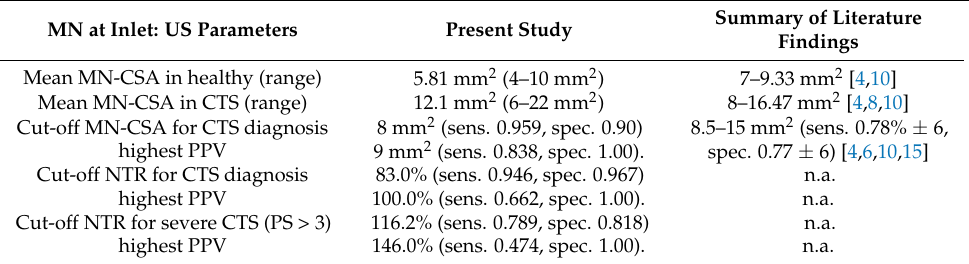
Table 2. MN-CSA and NTR in healthy patients and